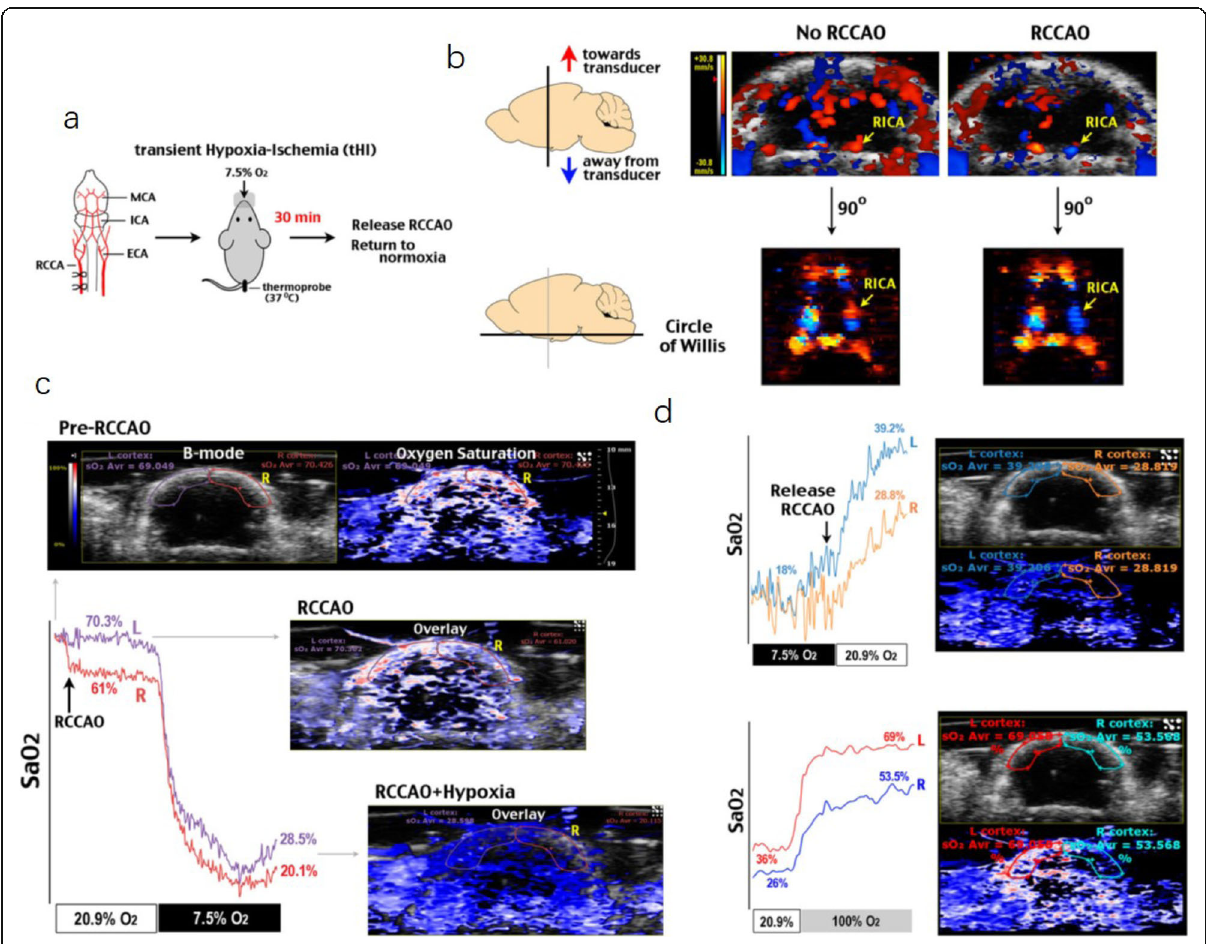
Fig. 2 tHI caused prolonged deficits in cortical oxygenation. Doppler flow imaging and 3D reconstruction showed reduced perfusion in the ipsilateral hemisphere and the reversal of blood flow in the RICA in the Circle of Willis after RCCAO. Co-registered anatomical image (B-mode micro-US) and StO 2 (StO 2 in a red-white-blue color-map by PAI) showed bilateral difference in StO 2 between the left (L, contralateral) and right (R, ipsilateral) cerebral cortex of an adult C57BL/6 mouse after RCCAO in normoxic (20.9% O 2 ) or hypoxic (7.5% O 2 ) conditions